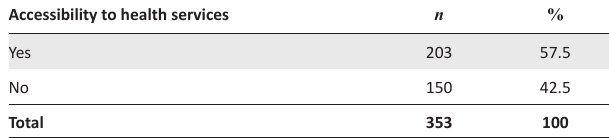
TABLE 3: Type of health service respondents used ( N = 353). TABLE 4a: Health services accessibility ( N = 353).